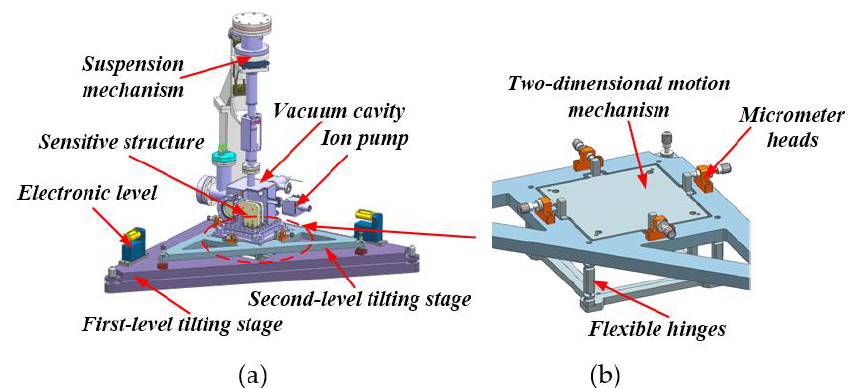
Figure 9. Schematic of the torsion pendulum facility. ( a ) The main components of the torsion pendulum facility; ( b ) Two-dimensional space non-coupling motion mechanism.